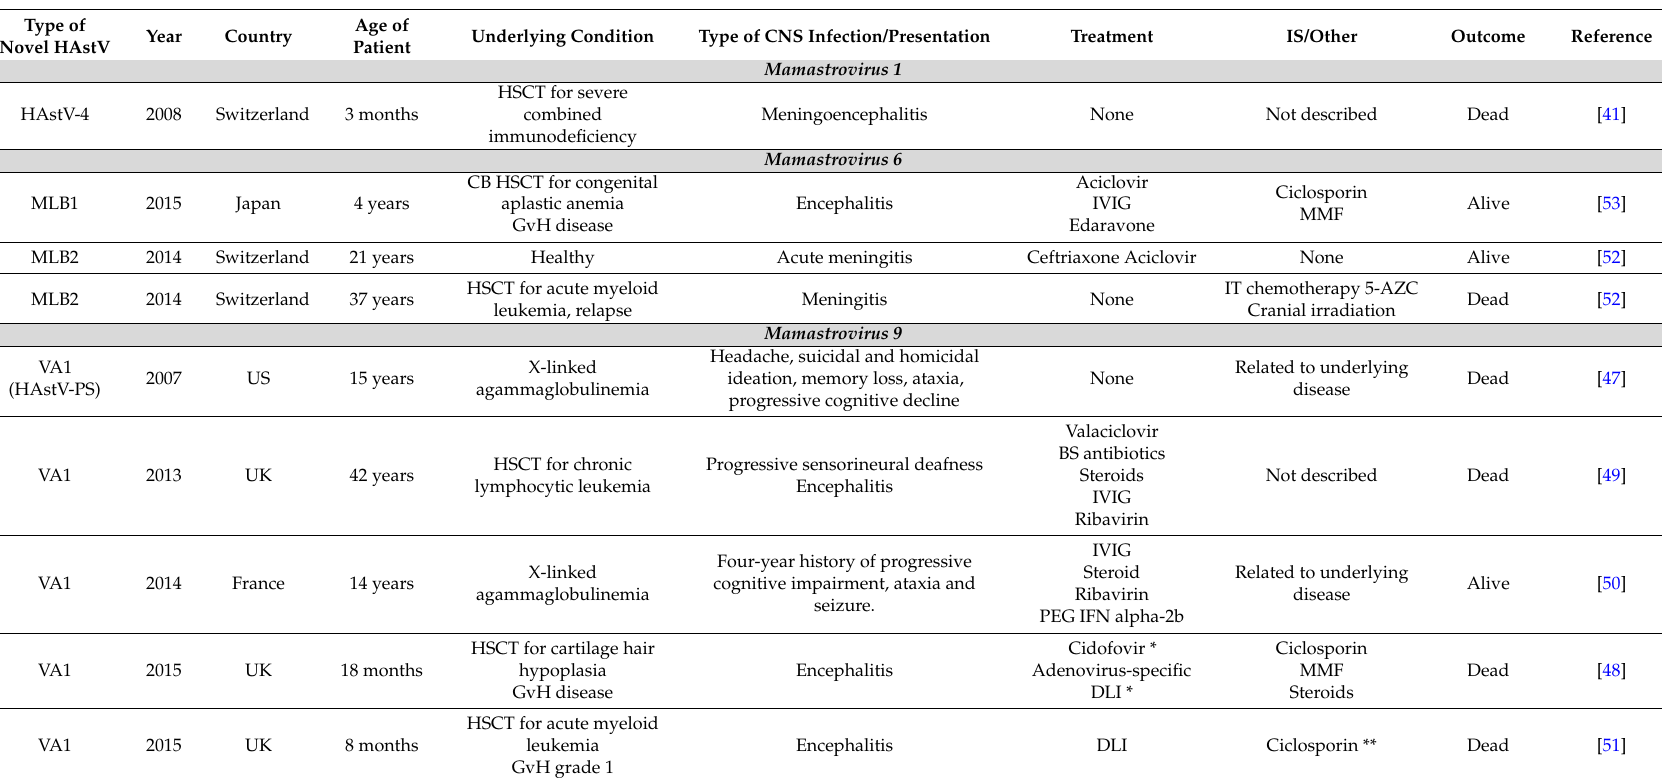
Table 2. Summary of the 9 case reports of HAstV infections causing severe central nervous system (CNS) infections in humans (adapted from [50] and updated). Type of Novel